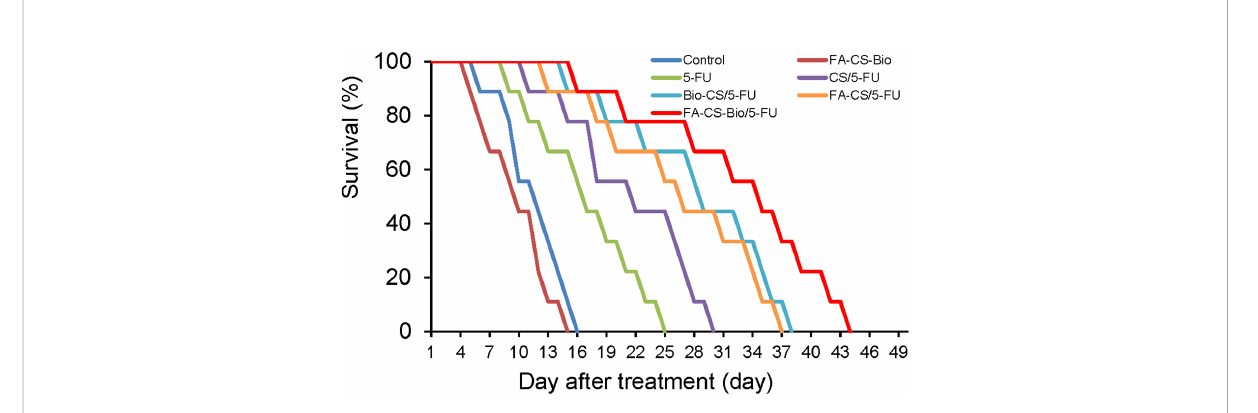
FIGURE 4 Survival analysis of different 5-FU nanoformulations in mouse orthotopic liver cancer